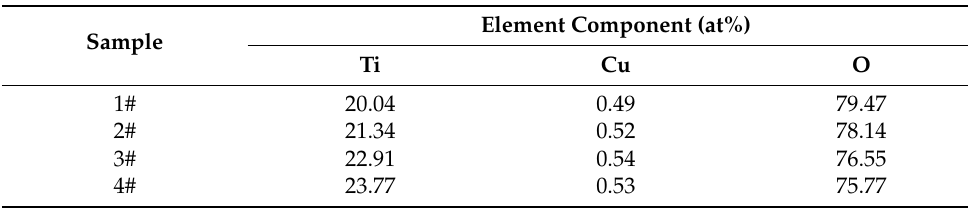
Table 2. The element content of 1#, 2#, 3# and 4#